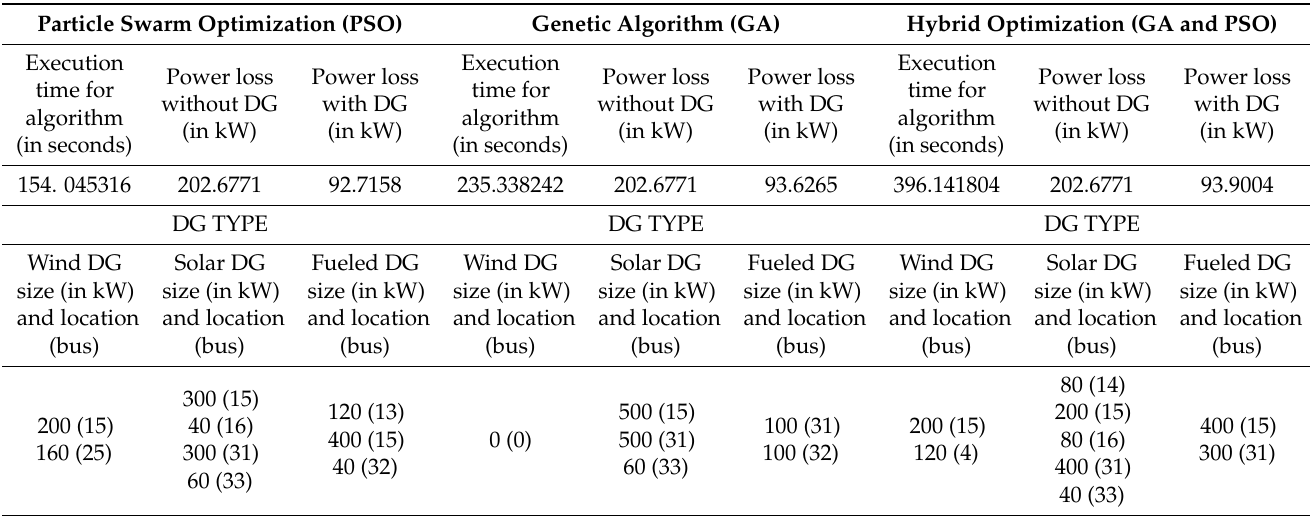
Table 8. Results for optimal DGs size and their corresponding optimum location using by PEM for scenario-2 using different metaheuristic optimization